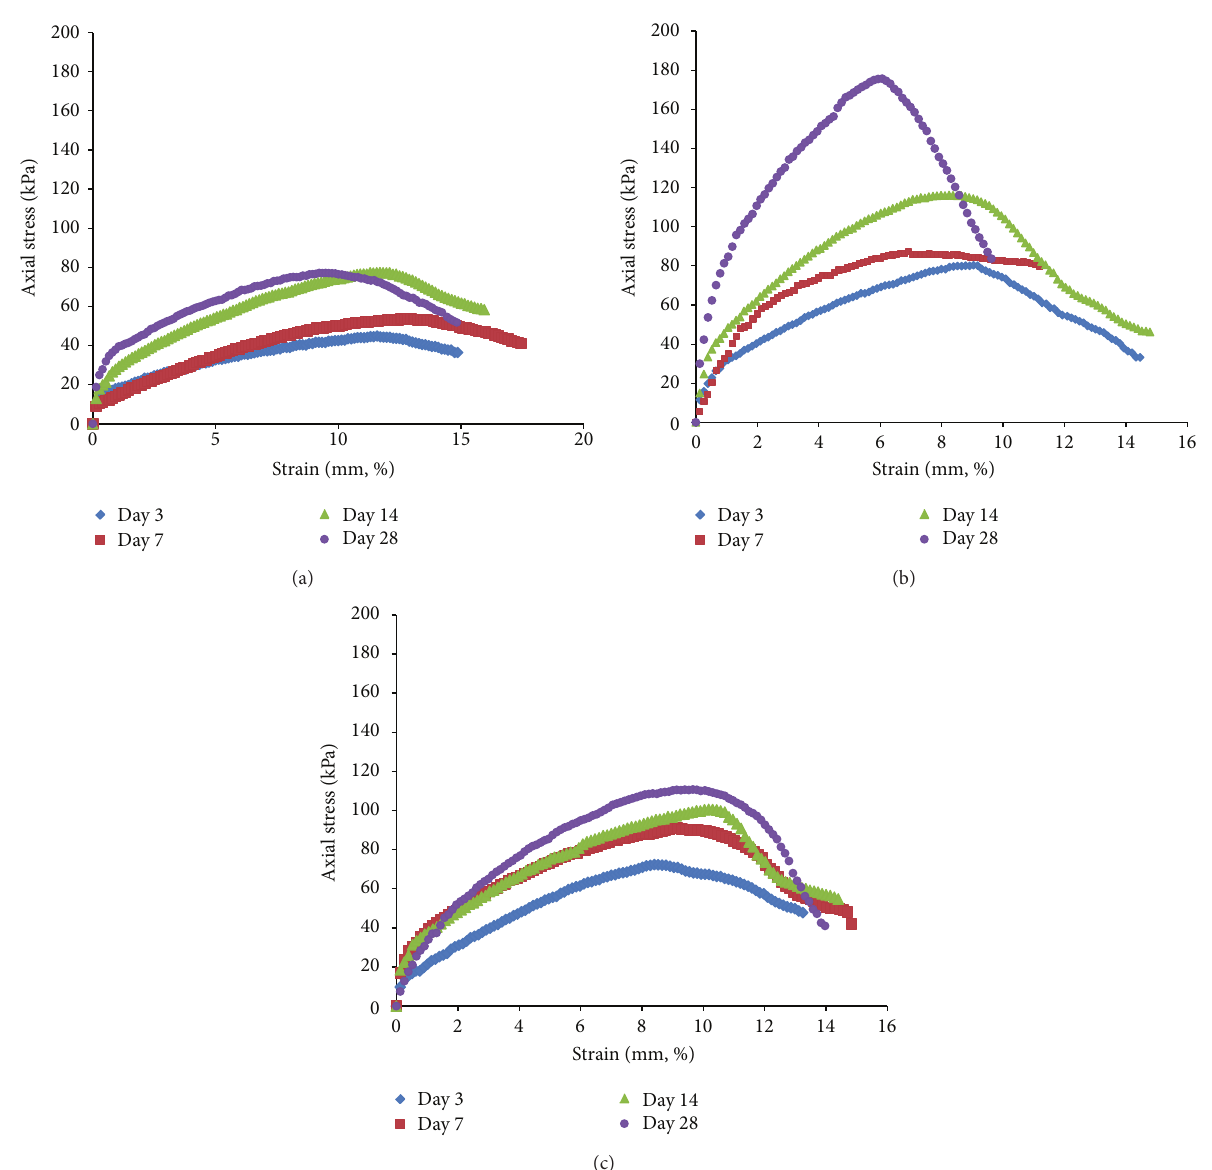
Figure 4: Compression curves for the solidified